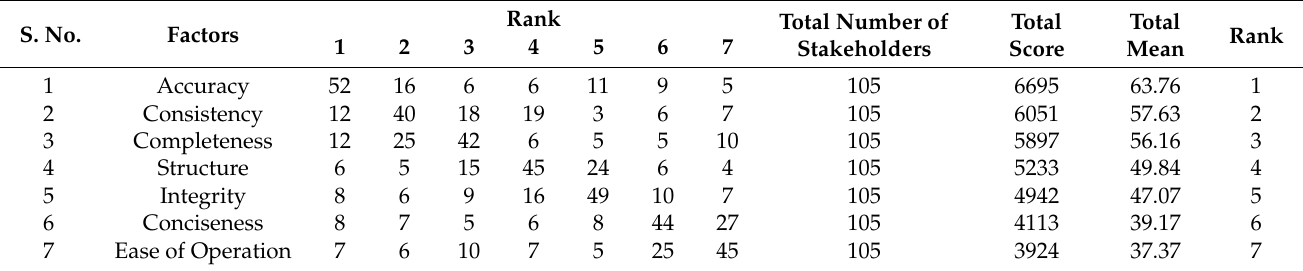
Table 6. Ranking of dimensions within the syntactic category of the semiotic framework.